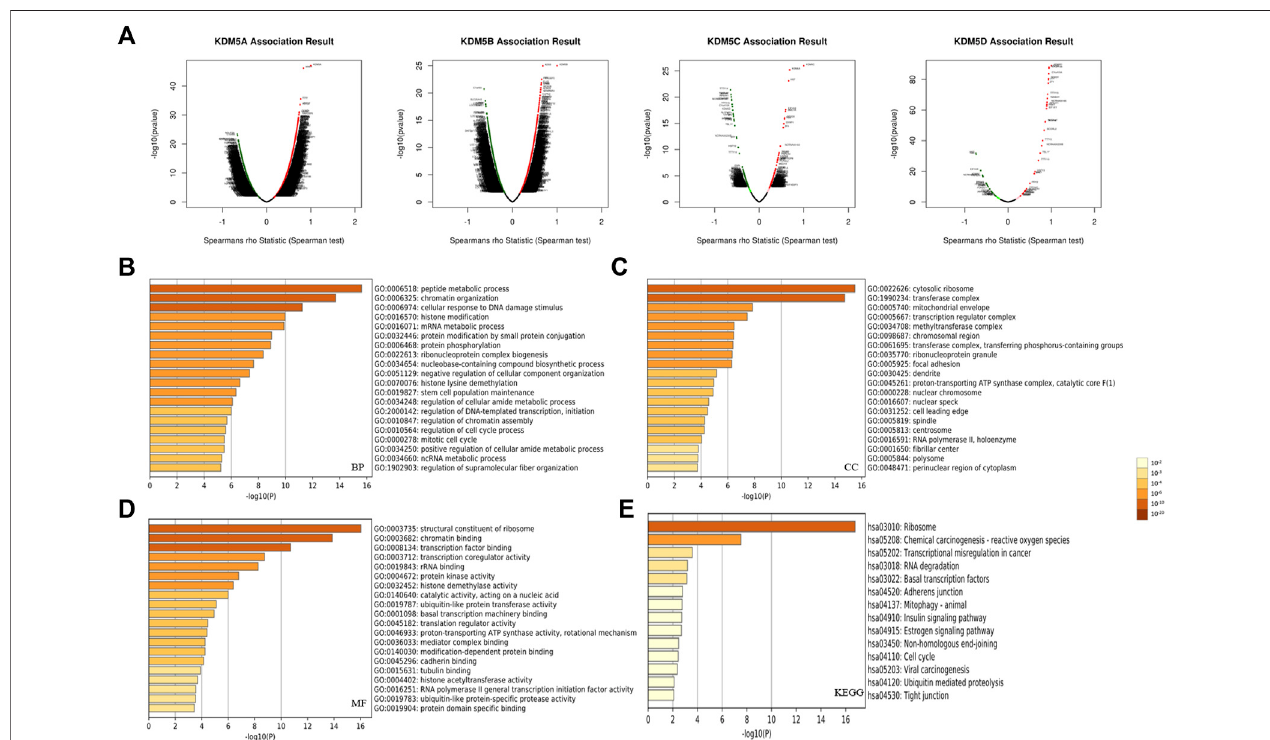
FIGURE4| FunctionalenrichmentanalysisoftheKDM5familyandits800co-expressedgenesinpatientswithPAAD. (A) AvolcanoplotoftheKDM5familyandits co-expressed genes in pancreatic cancer; (B) The GO enrichment of the BP terms of 800 co-expressed genes; (C) The GO enrichment of the CC terms of 800 co- expressed genes; (D) The GO enrichment of the MF terms of 800 co-expressed genes; (E) The KEGG enrichment of the 800 co-expressed genes.